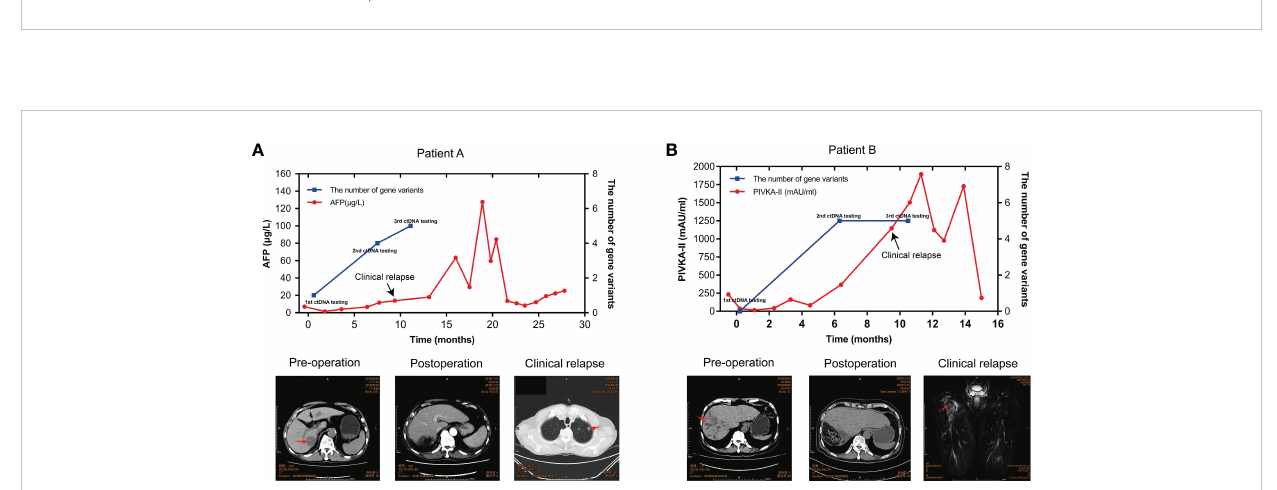
FIGURE 5 ctDNA dynamic monitoring. The dynamical changes in the number of MRD monitoring gene variants, the level of AFP/PIVKA-II in plasma samples, and imaging results of HCC patients A (A) and B (B) during HCC progression. HCC, hepatocellular carcinoma; MRD, minimal residual disease; AFP, alpha-foetoprotein; PIVKA-II, a protein induced by vitamin K absence or antagonist